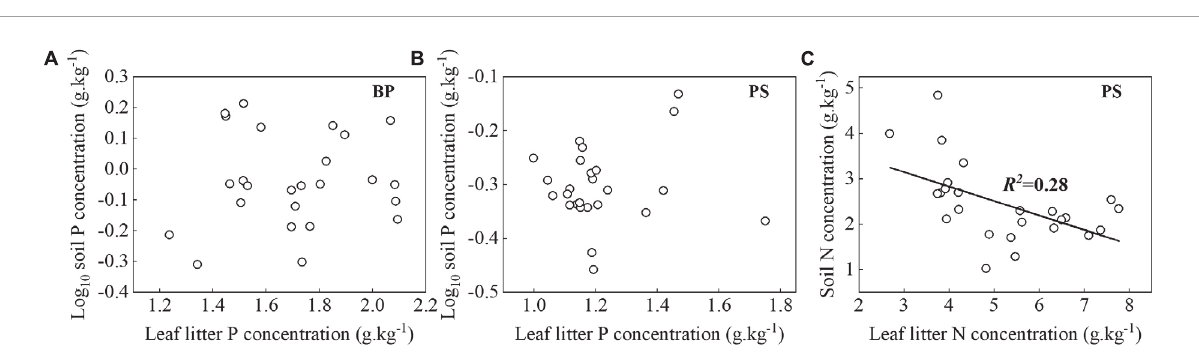
FIGURE7 Relationships between leaf litter P concentration of BP and PS (A,B) and leaf litter N concentration of PS (C) and soil P and N concentrations, respectively. Lines were plotted for relationships with p <